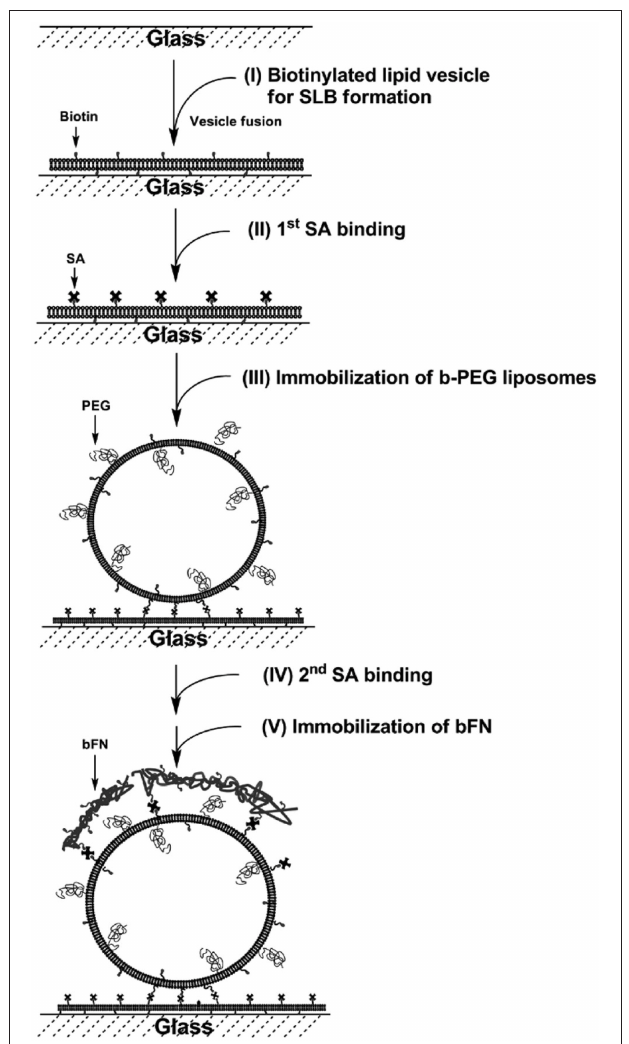
FIGURE 4 | Fibronectin-liposome functionalized surfaces based on a biotinylated lipid bilayer (FN-liposome-SLB). Construction of the model surface involves five steps: (I) formation of SLB, (II) first layer of streptavidin binding, (III) immobilization of b-PEG liposomes, which may contain dye-labeled lipids, or encapsulate DOX/fluorescent dye, (IV) the second layer of streptavidin binding, and (V) immobilization of biotinylated-fibronectin (bFN). Reprinted with permission from Tseng and Chang (2012). Copyright 2012 American Chemical